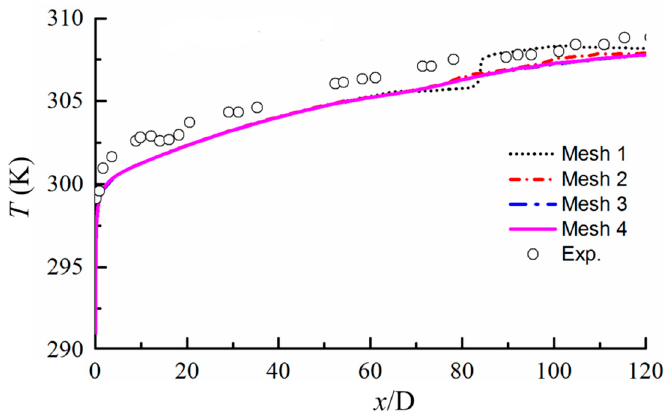
Figure 5. Variation of wall temperature in the axial direction with different meshes ( q = 56.7 kW/m 2 ).